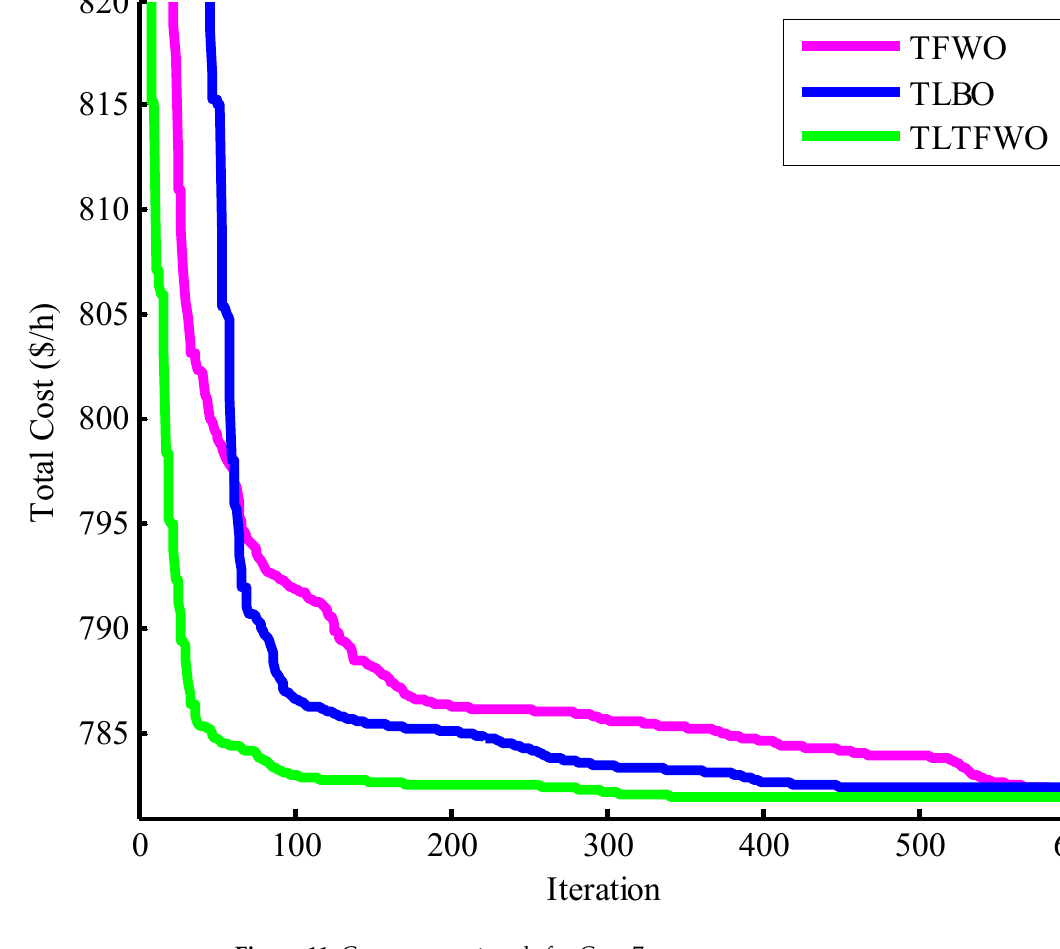
Figure 11. Convergence trends for Case 7.